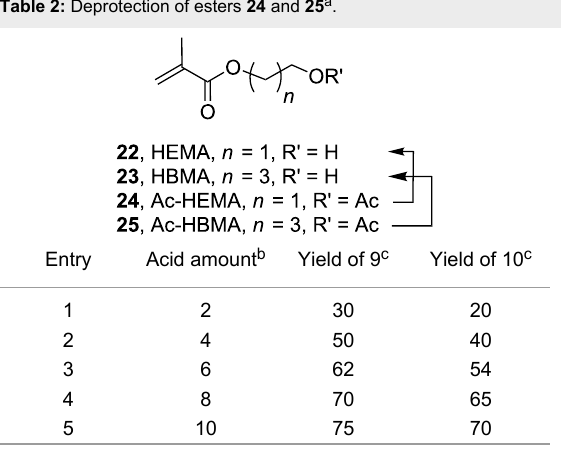
Table 2: Deprotection of esters 24 and 25 a